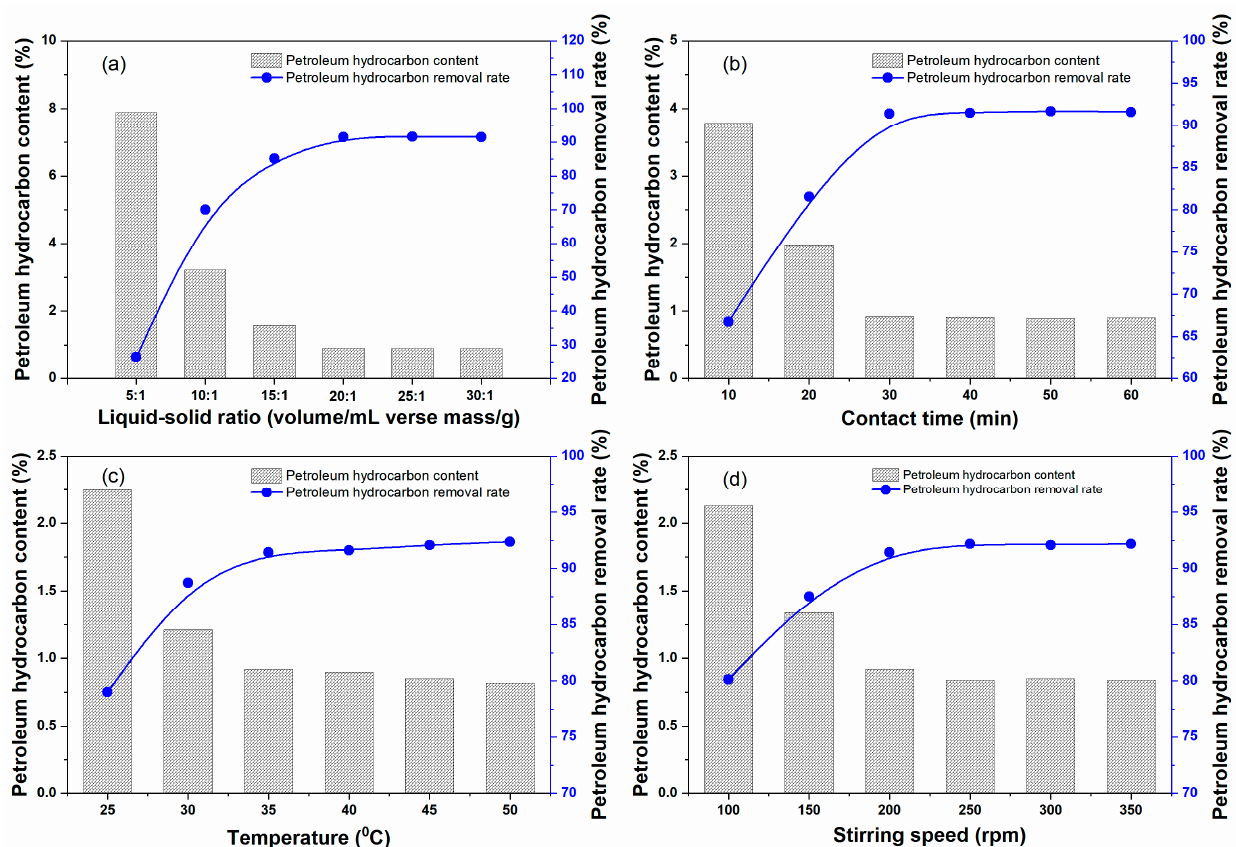
Figure 3. Influence of liquid–solid ratio ( a ), contact time ( b ), temperature ( c ), and stirring speed ( d ) on residual petroleum hydrocarbon content and petroleum hydrocarbon removal rate.